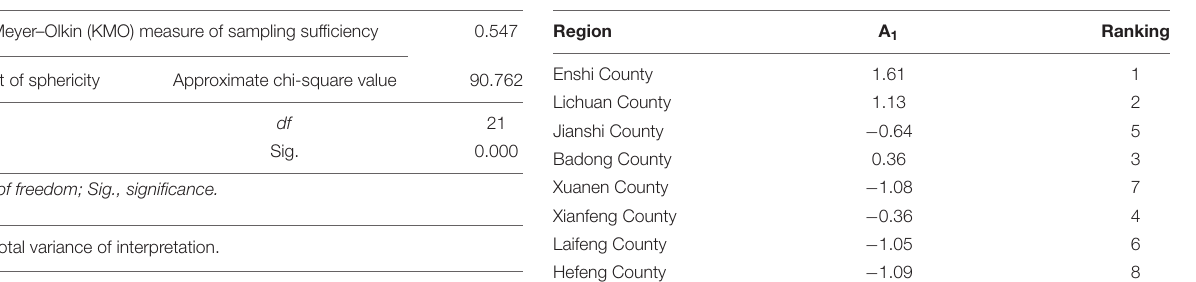
TABLE 7 | Scores and rankings of EAP’s tourism core competitiveness (A 1 ).